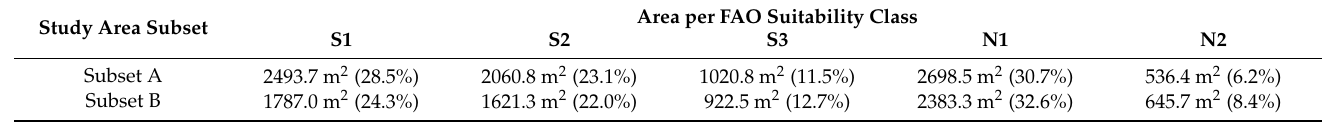
Table 3. The absolute and relative area of FAO suitability classes for tangerine cultivation. Study Area Sub- set